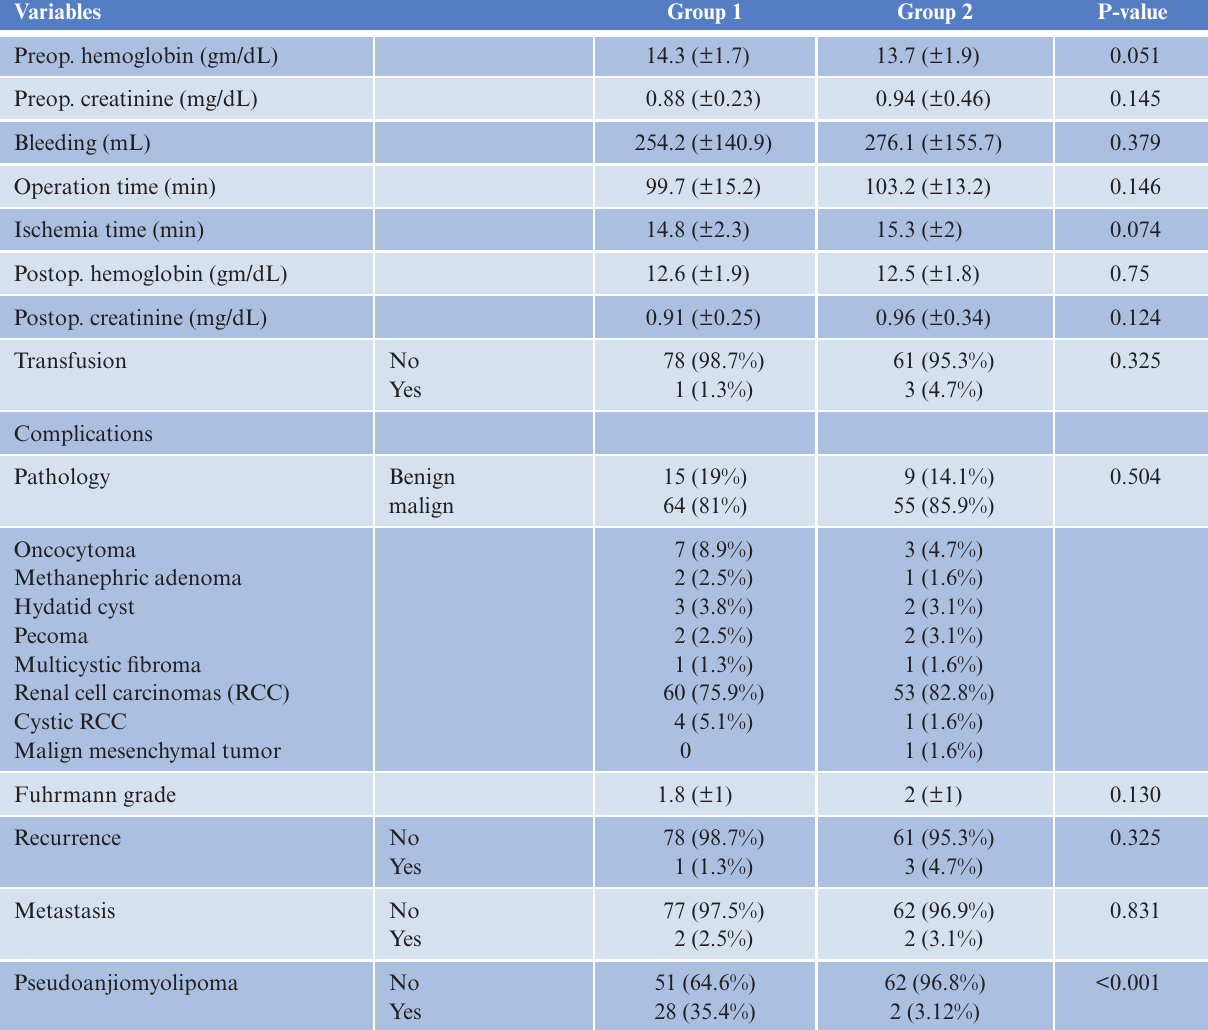
Table 2: Laboratory, preoperative, and postoperative results of the